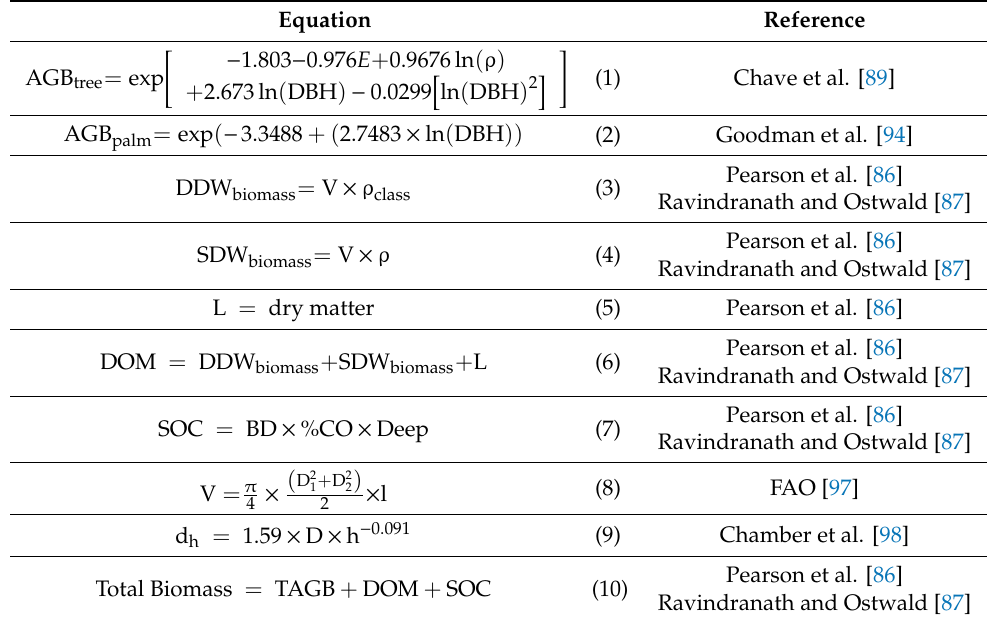
Table 1. Equations for biomass and carbon stock